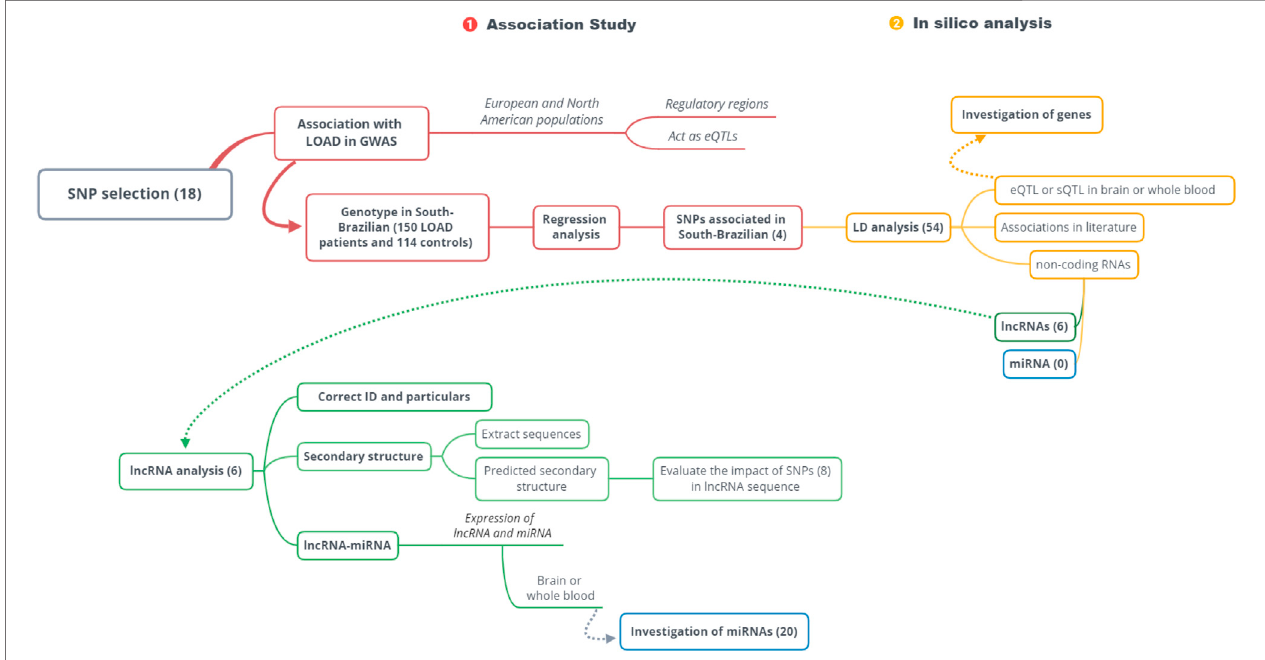
FIGURE 1 | Work fl ow. This study is divided into two stages: 1, association study; 2, in silico analysis. Only the associated variants in the studied population (South Brazilian) followed in silico analysis. SNP: single-nucleotide polymorphism; LOAD: late-onset Alzheimer ’ s disease; GWAS: genome-wide association studies; eQTL: expression quantitative trait locus; sQTL: splicing quantitative trait locus; LD: linkage disequilibrium; lncRNAs: long non-coding RNAs; miRNAs: microRNAs.